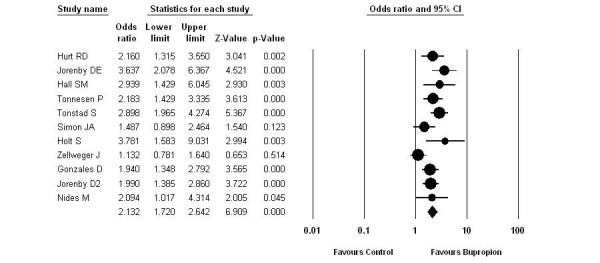
Random Effects Meta-Analysis. Bupropion vs. Controls at 3 months. I2 = 53.6%.